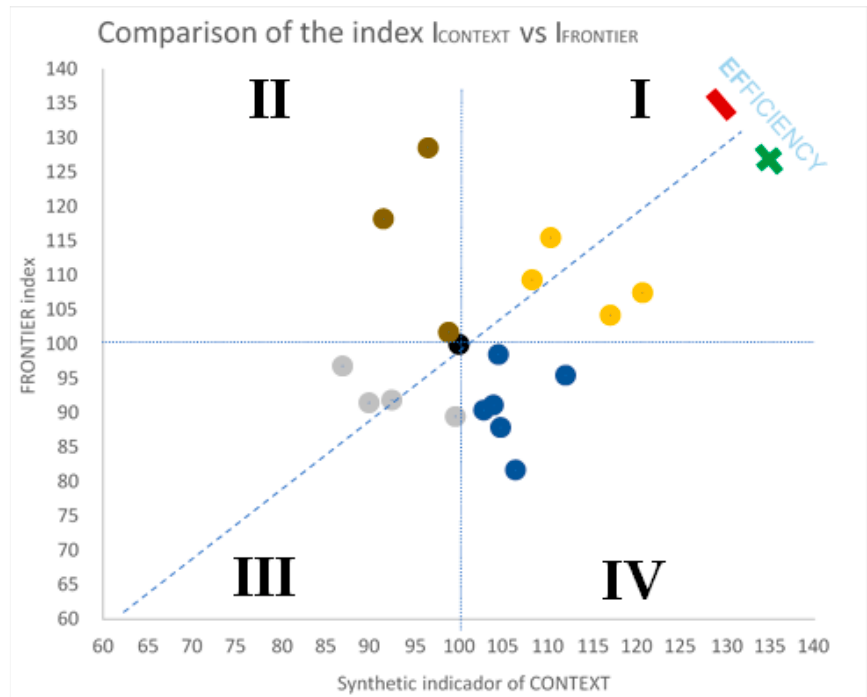
Figure 2. Comparison of the index context vs. frontier.